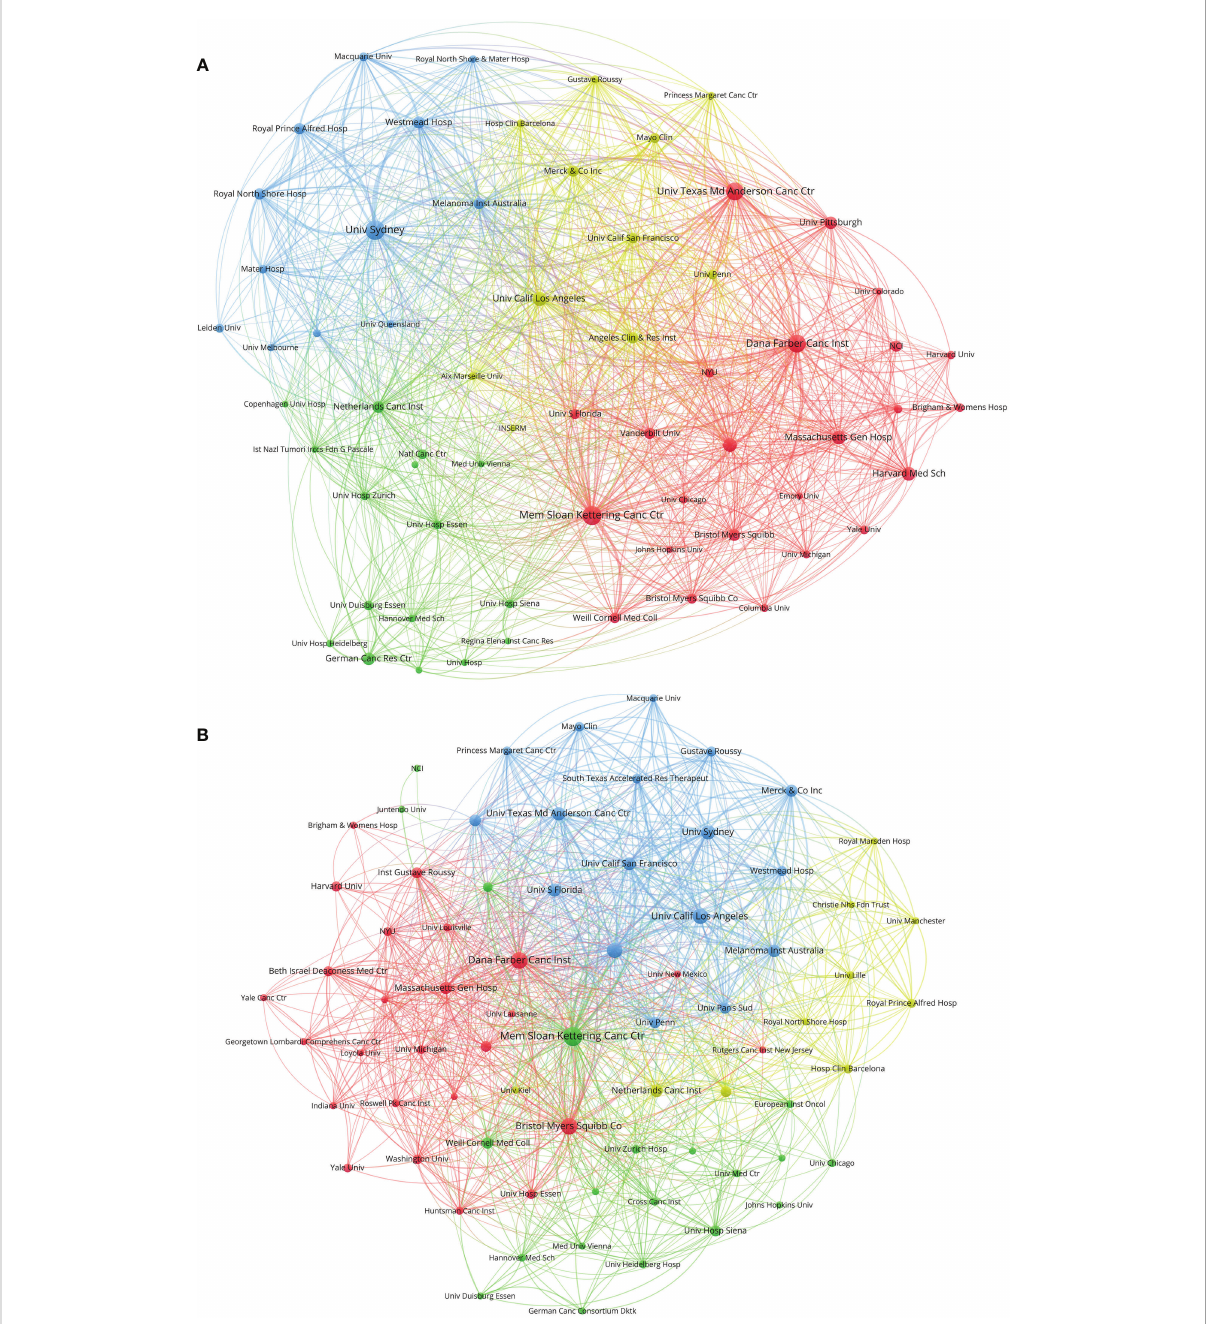
FIGURE 5 (A) Network visualization of institutions with at least 20 papers related to melanoma immunotherapy. (B) Network visualization of institutions with at least three top-papers related to melanoma immunotherapy. The circle size represents the number of papers. The breadth of the curves represents the connection strength. The institutions in the same color have stronger collaboration with each